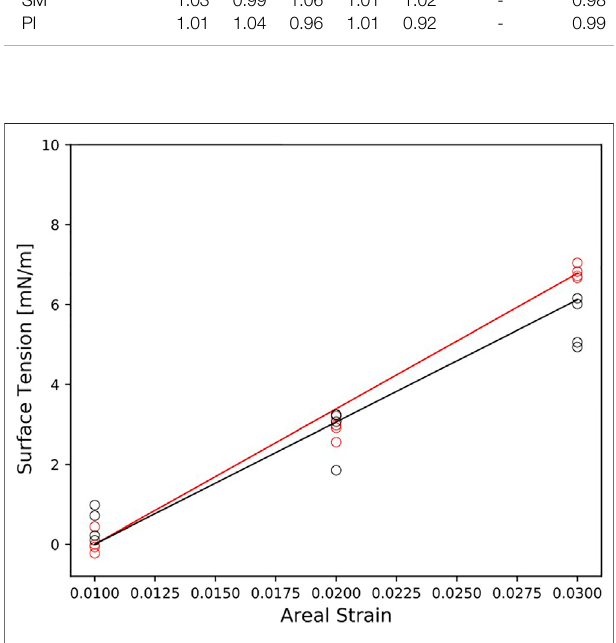
FIGURE 3 | Surface tension as function of the areal strain for myelin and node-of-Ranvier model, colored in red and black respectively. Reported data (circles)correspondstotheaverageon1 μ stime-window.Theslopeofthelineis K A .